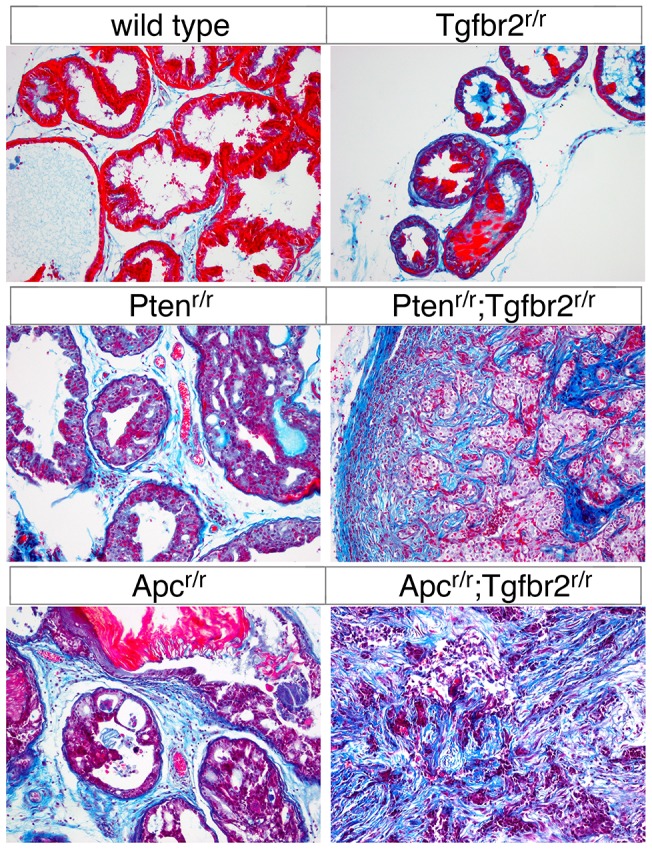
Increased stroma in Apc null prostates. Masson's Trichrome stained prostate sections are shown, from mice at the following ages. Wild type: 25 weeks, Ptenr/r: 18 weeks, Apcr/r: 36 weeks, Tgfbr2r/r: 18 weeks, Ptenr/r;Tgfbr2r/r: 12 weeks, and Apcr/r;Tgfbr2r/r: 17 weeks.